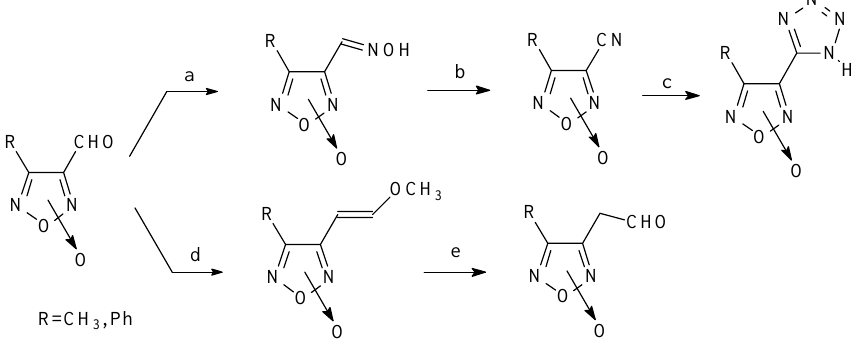
Figure 2. Conditions: (a) NH